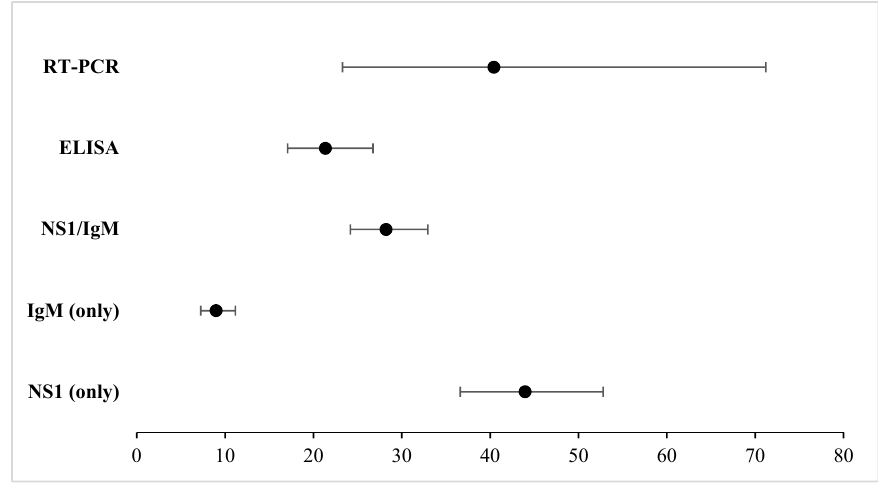
Figure 4. Summary findings of DOR when subgrouping ICTs: NS1 (only), IgM (only), NS1/IgM. Additionally, ELISA and RT-PCR were pooled to note reference test effects on DOR of